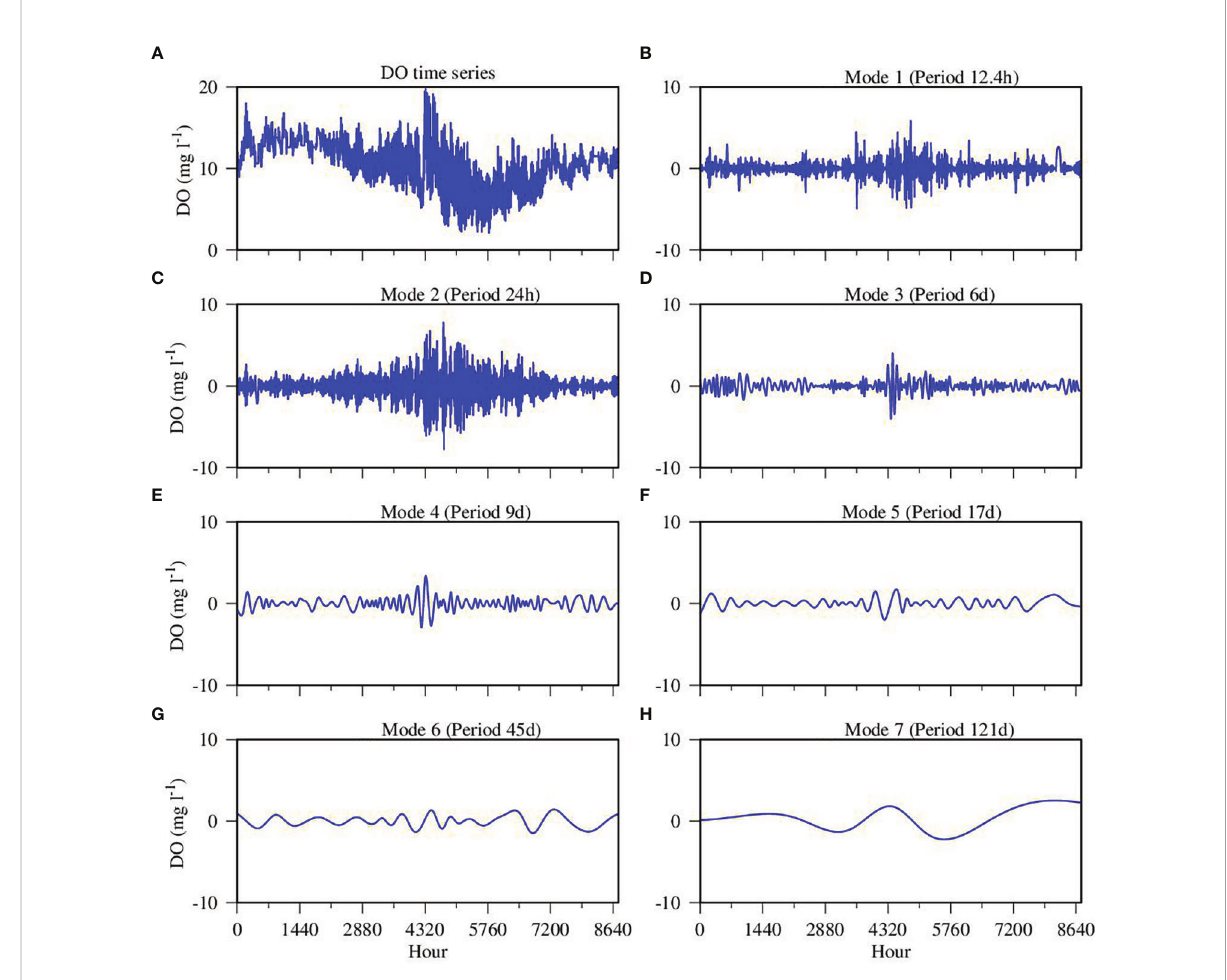
FIGURE 6 Empirical Mode Decomposition (EMD) of simulated DO time series data at the upper estuary station XHH3851. (A) original time series data; (B) mode 1; (C) mode 2; (D) mode 3; (E) mode 4; (F) mode 5; (G) mode 6; (H) mode 7. The main period of each mode is given in the panel